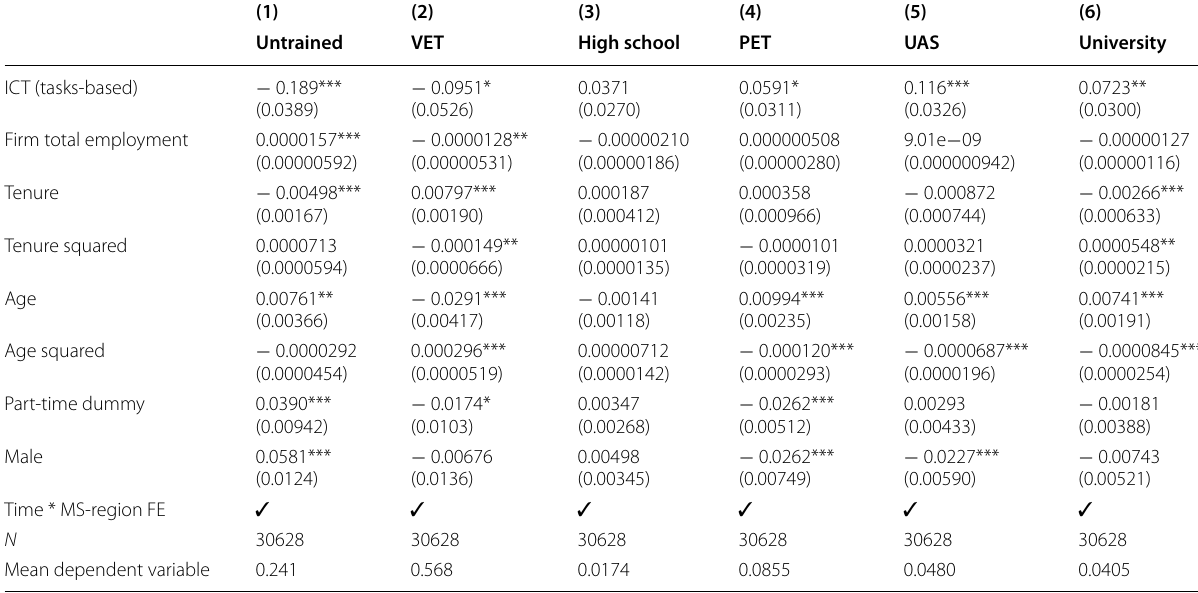
Table 6 Pseudo-panel FE estimations: